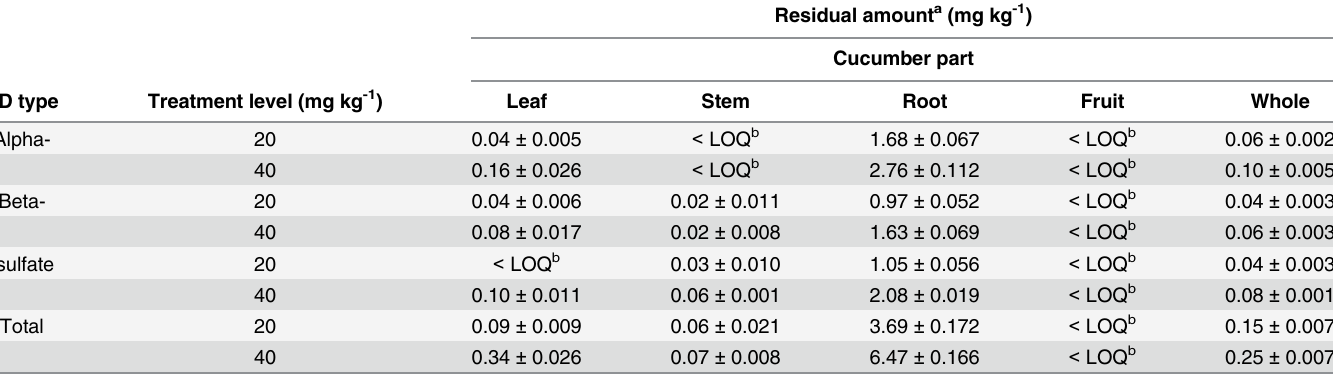
S1 Fig. Total ion chromatogram and mass spectra of α - (a), β - (b) isomers and sulfate- metabolite (c) of ED analyzed using GC-MS. (TIF) S2 Fig. Chromatograms for recovery tests of α - and β -isomers and sulfate-metabolite of ED with 1.0 mg kg-1-spiked concentration in whole plants of cucumbers cultivated during non-ED amended indoor (a, b) and outdoor (c, d) tests. (a, c — spiked samples; b, d — con- trol samples). (TIF) S3 Fig. Chromatograms for recovery tests of α -, β -isomers and sulfate-metabolite of ED with 1.0 mg kg -1 -spiked concentration in non-ED amended soils during indoor (a, b) and outdoor (c, d) tests. (a, c — spiked samples; b, d — control samples) (TIF) S4 Fig. Change in length (a) and weight (b) of cucumber parts during the indoor test. (TIF) S1 Table. Recovery rates of ED isomers and their sulfate metabolite in soil and each cucum- ber compartment.